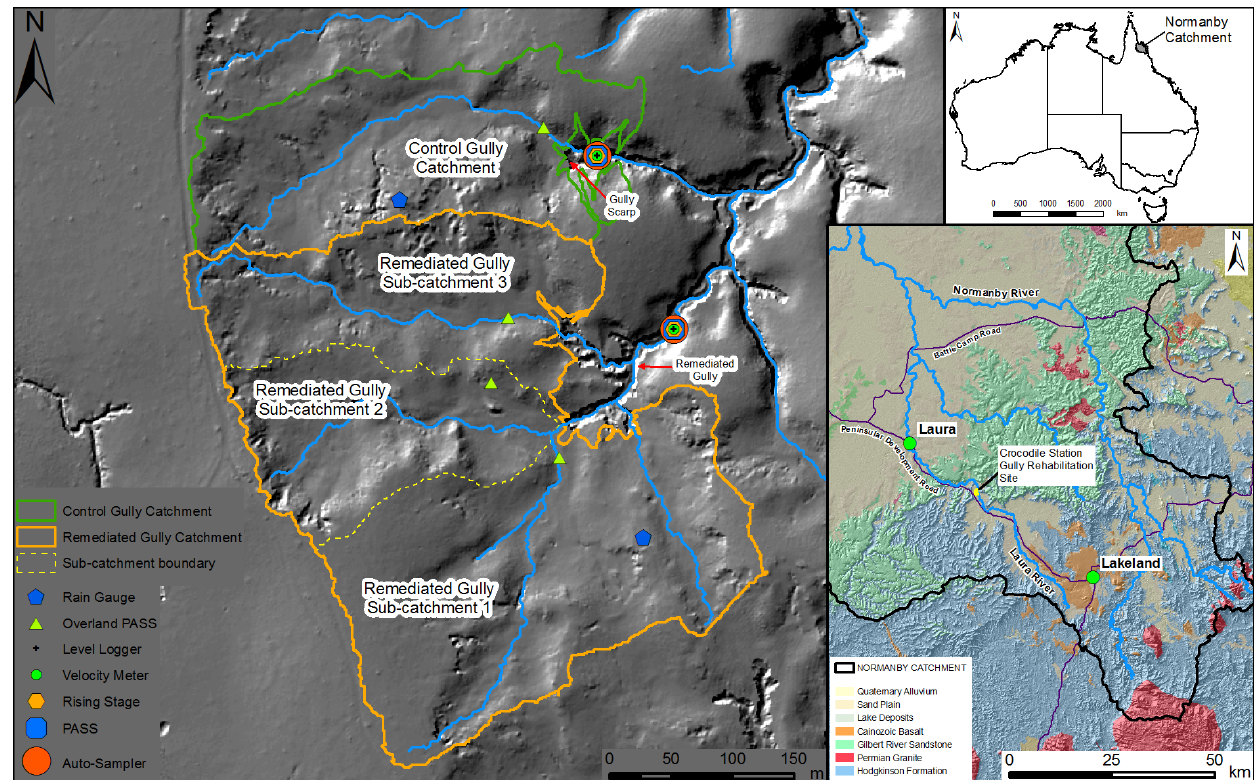
Figure 1. Topographic map of the study site, including surface geology and gully locations. Source: Geoscience Australia (2019). PASS – pumped active suspended sediment (PASS) sampler; overland PASS – a PASS sampler used to sample water flowing overland (i.e. runoff); rising stage – single-stage sampler (i.e. rising stage sampler). Note: the overland PASS sampler in sub-catchment 3 of the remediated gully was deployed several metres away from the flow line inferred by surface geology due to the redirection of flow associated with vegetation and termite